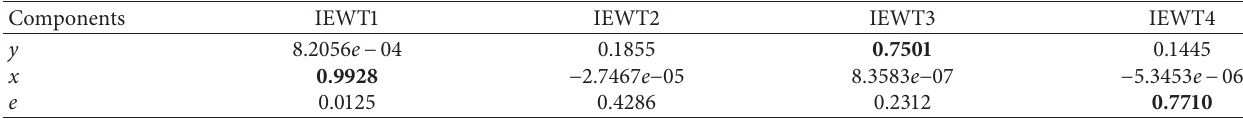
Figure 5: Time-domain diagram of IEWT components. Table 1: Correlation coefficient.